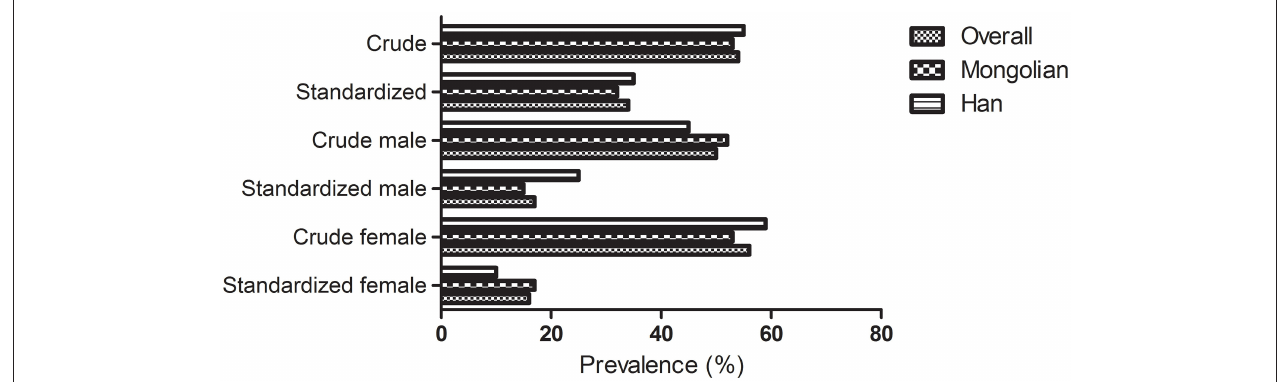
FIGURE 1 | Crude and standardized prevalence of dry eye disease stratified by gender and ethnicity in the grasslands.